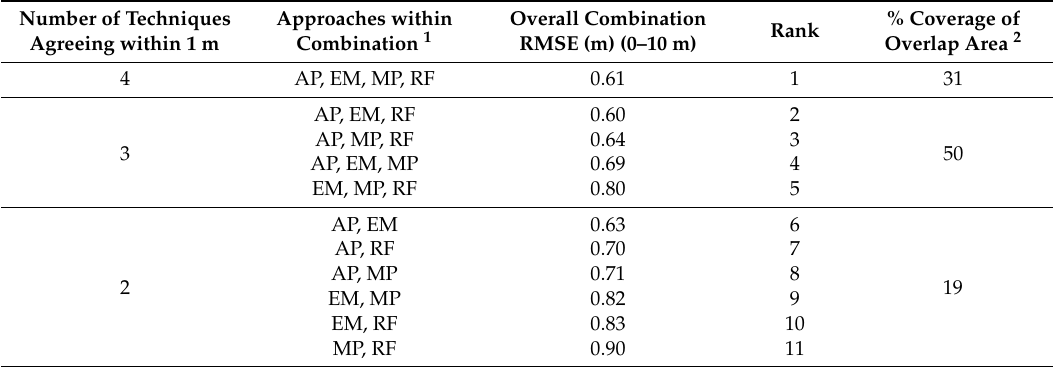
Table 4. Overall root mean square error (RMSE) and rank of each technique combination for the level of confidence approach. The percentage of the overlap area captured by four, three and two agreeing techniques is also